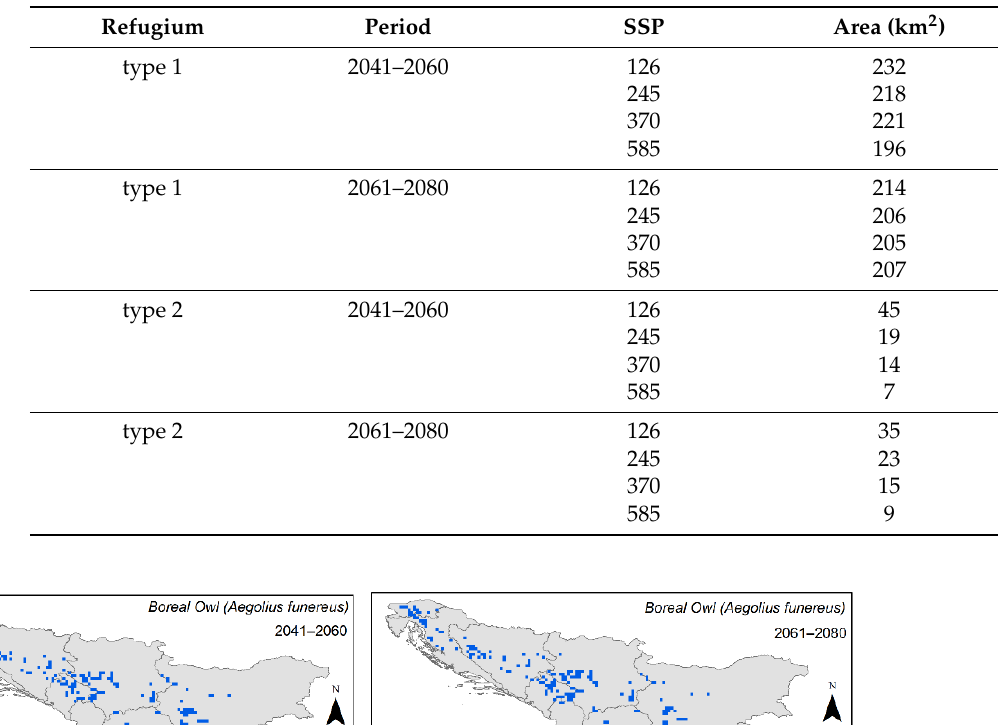
Table 6. Extent of two types of refugia (km 2 ) for Boreal Owl ( Aegolius funereus ). Area of type 1